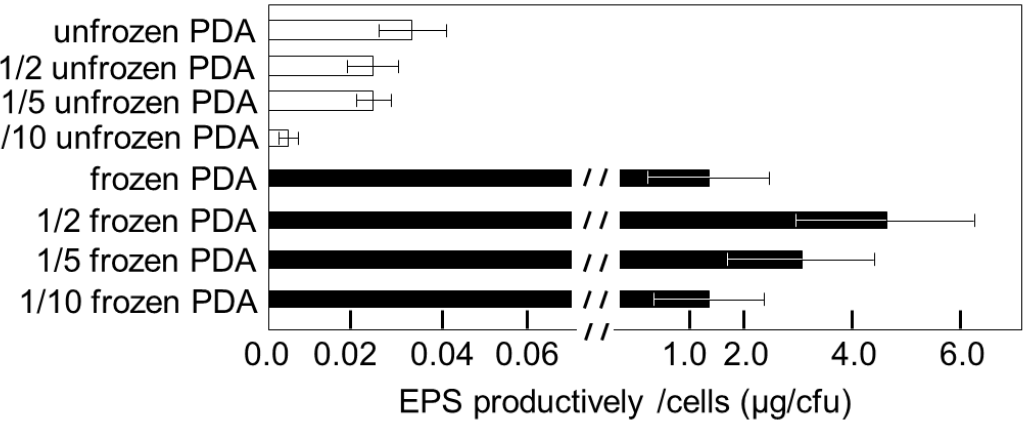
Figure 5. Effect of cultural conditions on extracellular polysaccharide productivity of G. antarctica S4B. Cultures were incubated at − 1 °C for 20 weeks on frozen PDA or 5 weeks on unfrozen PDA. Error bars indicated SD ( n = 3).